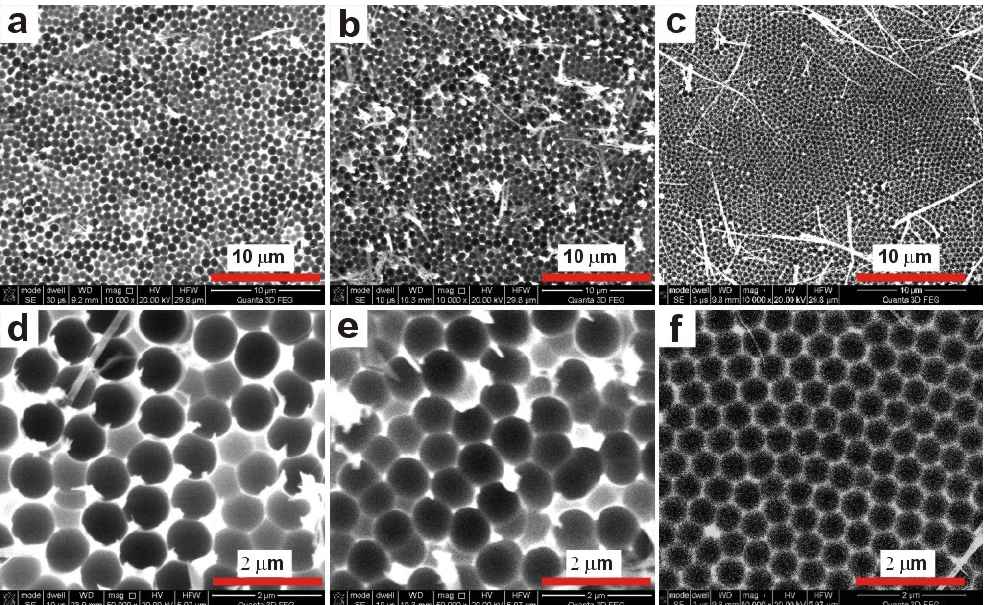
Figure 2. SEM images (upper row—magnification 10,000×, lower row—magnification 50,000×) of the nano-concaves left on aluminum surface after AAO dissolution obtained by a 5-h anodization at 5 °C in 0.15 M ( a , d ), 0.25 M ( b , e ), and 0.5 M ( c , f ) malic acid solution at 300 V (0.15 M and 0.25 M) and 250 V (0.5 M).